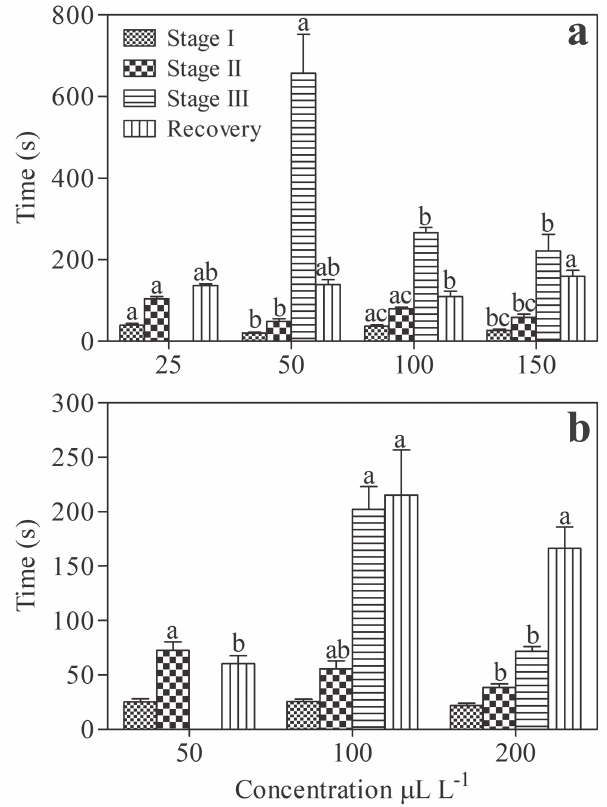
Fig. 1. Time required for induction and recovery of anesthesia in Serrasalmus eigenmanni . a . Aloysia triphylla essential oil. b . Lippia alba essential oil. Different letters indicate significant differences at each stage between treatments based on one-way ANOVA and Tukey tests (P <